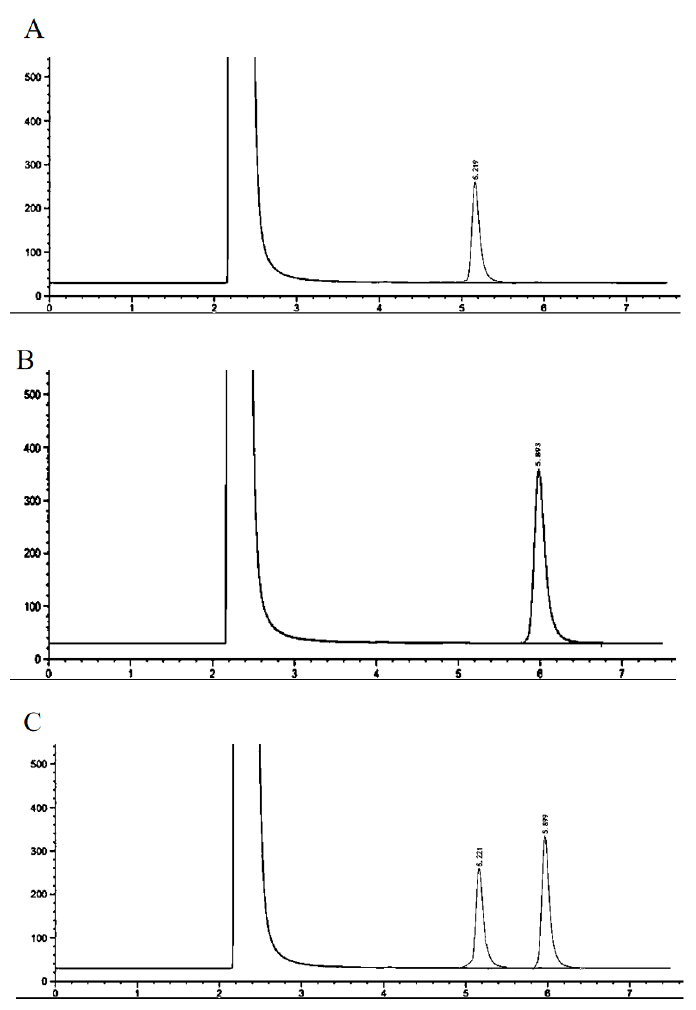
Figure 6. GC chart of substrates and products. ( A ) GC chart of myristic acid. ( B ) GC chart of isopropyl myristate. ( C ) GC chart of myristic acid and isopropyl myristate.